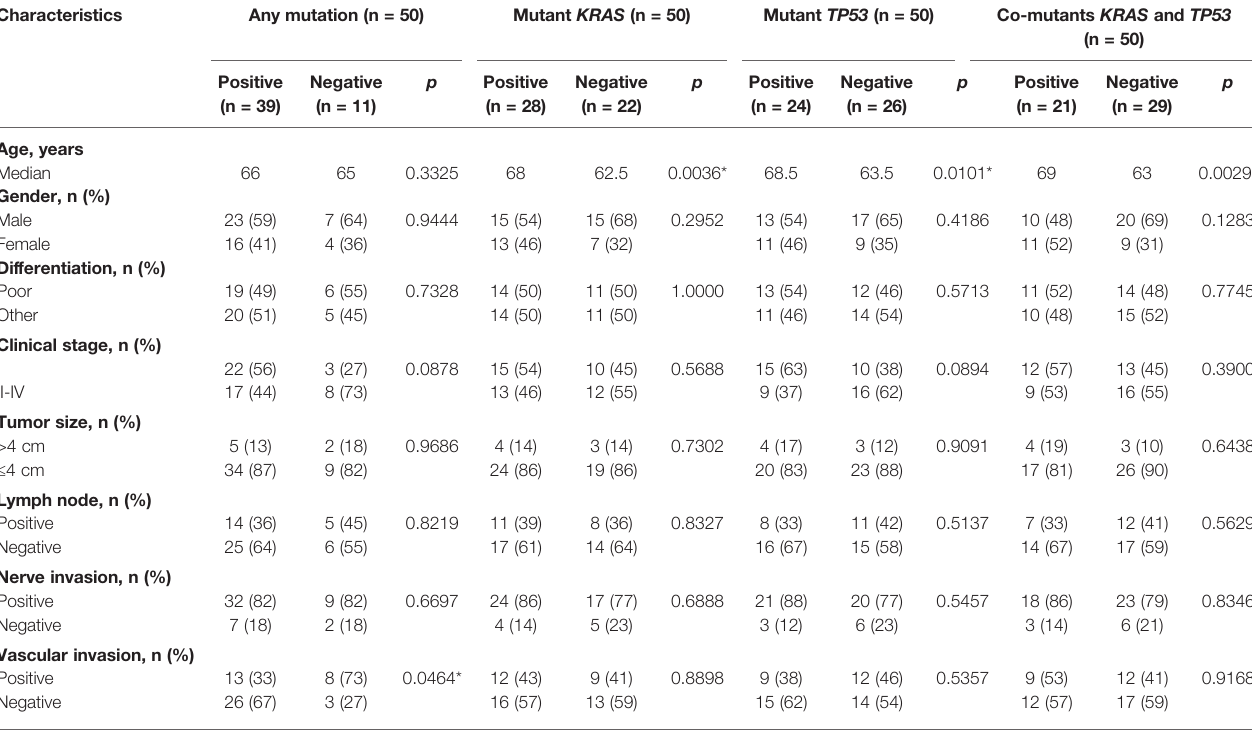
TABLE 1 | Correlation between clinical characteristics and genomic status of stroma.